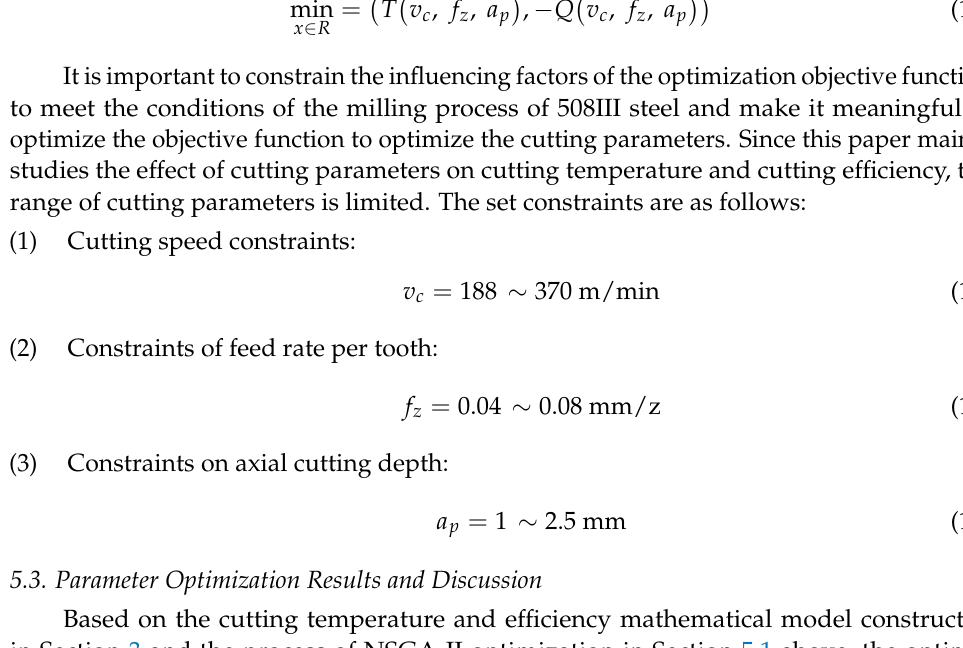
Figure 10. Flow diagram of the